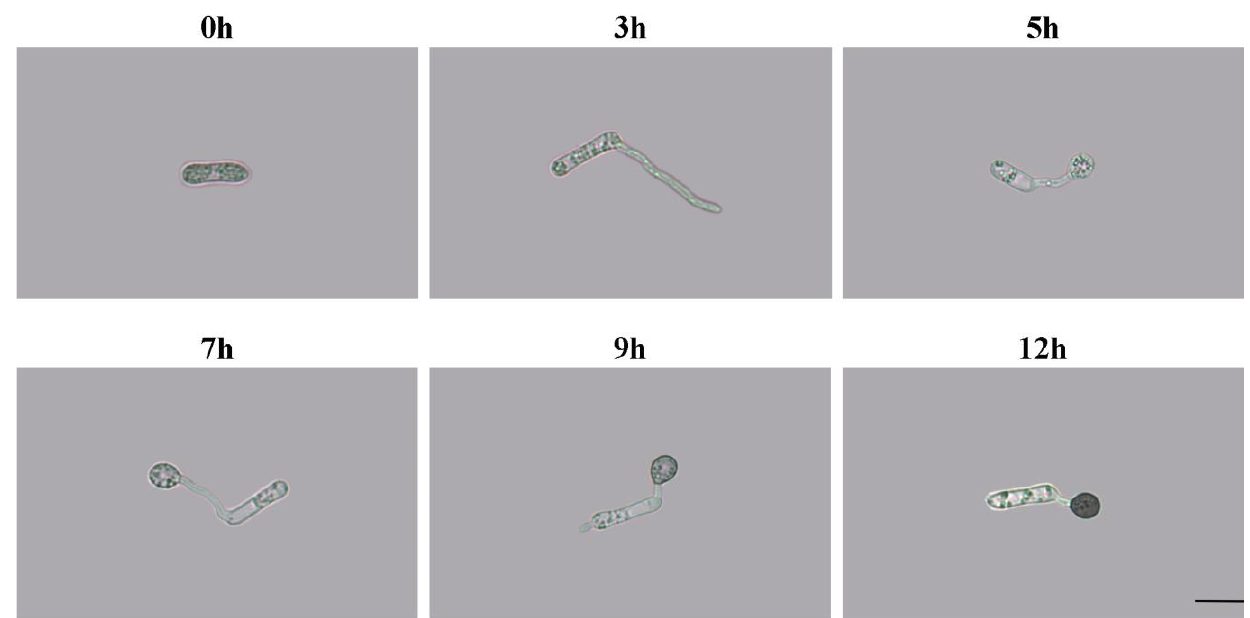
Figure 1. Morphological characteristics of the Colletotrichum gloeosporioides appressorium on a hy- drophobic surface at different time points (scale = 10 μm).